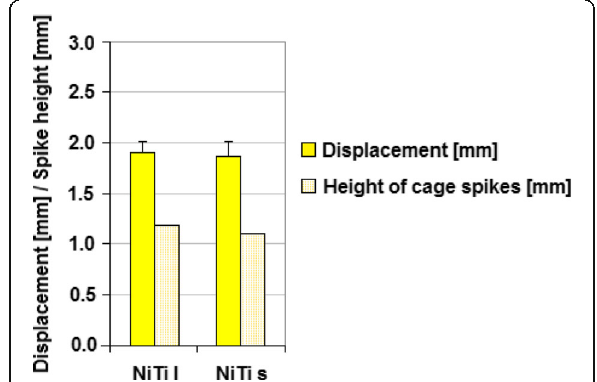
Fig. 5 Mean displacement at a force of 800 N and spike height of the